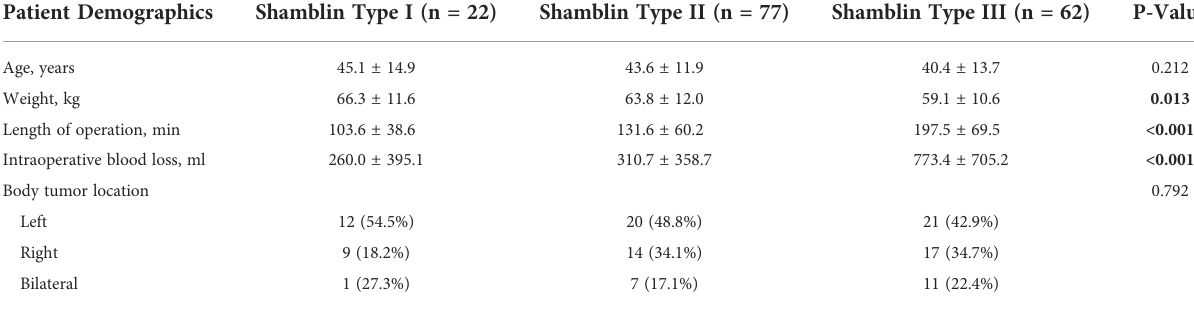
TABLE 2 Tumor and patient characteristics by Shamblin